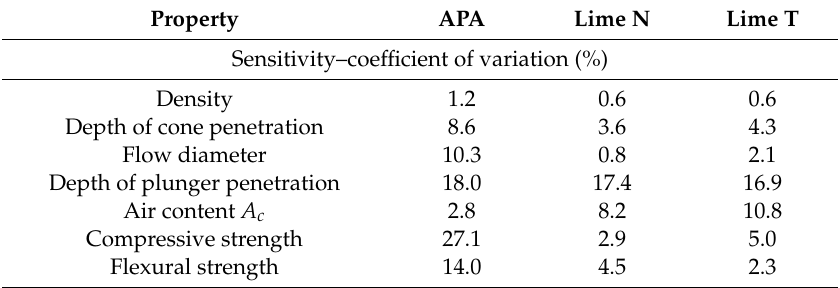
Table 12. The sensitivity of masonry mortars properties to mistakes in dosing lime or